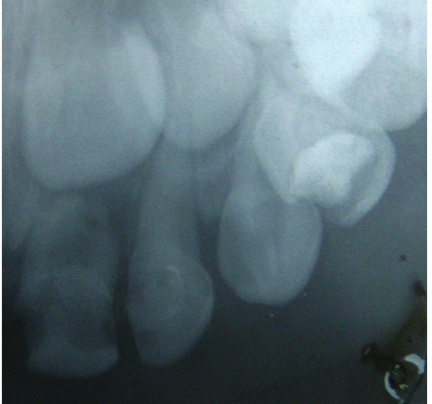
Figure 14: Final radiographic